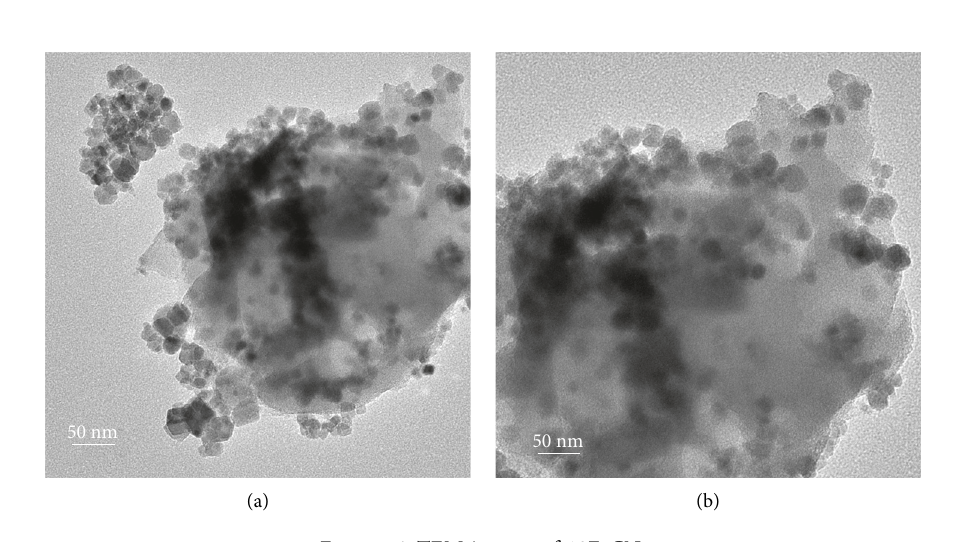
Figure 6: TEM images of